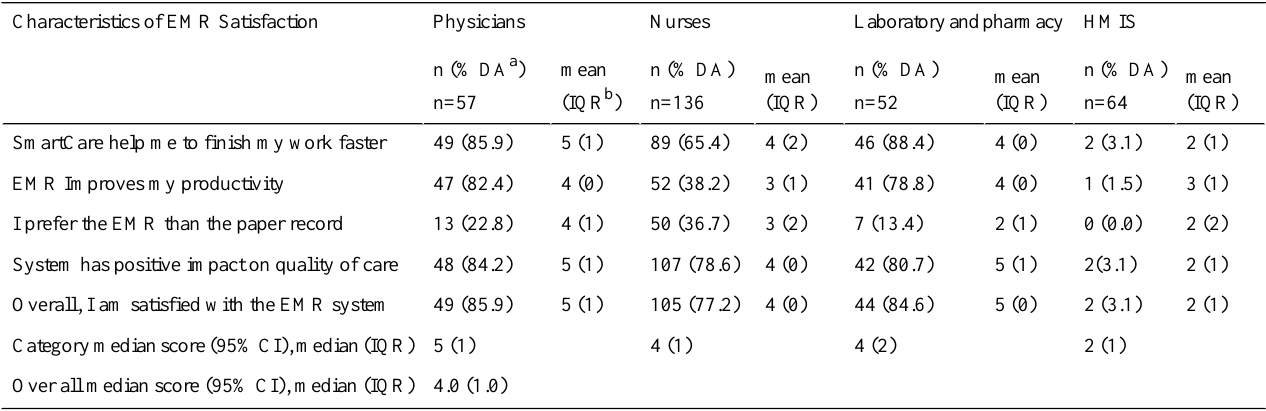
Table 5. Median satisfaction level of the study participants (n=309).